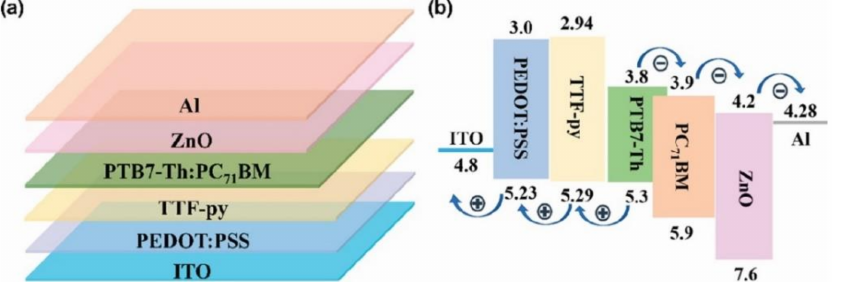
Figure 14. ( a ) Schematic illustration of device structure of ITO/PEDOT.PSS/TTF-py/PTB7- Th:PC 71 BM/ZnO/Al and ( b ) energy level diagram of an OSC with the TTF-py modified PEDOT:PSS as HTL. Adapted with permission from [268]. Copyright 2019, American Chemical